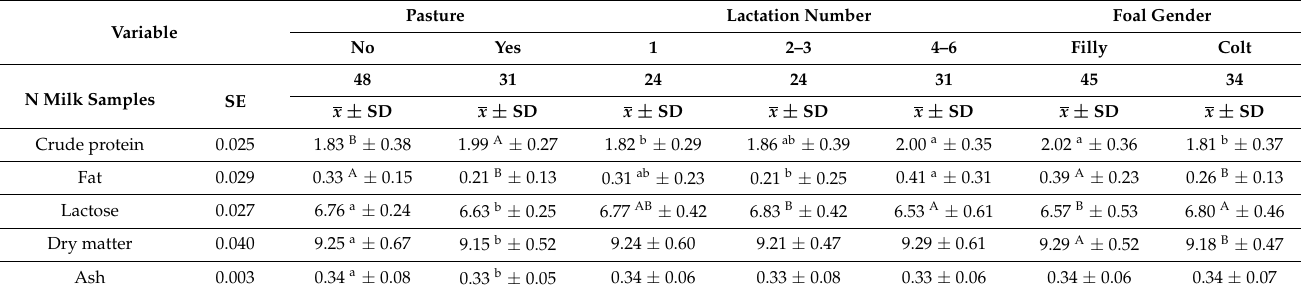
Table 2. Chemical composition of horse milk (%).